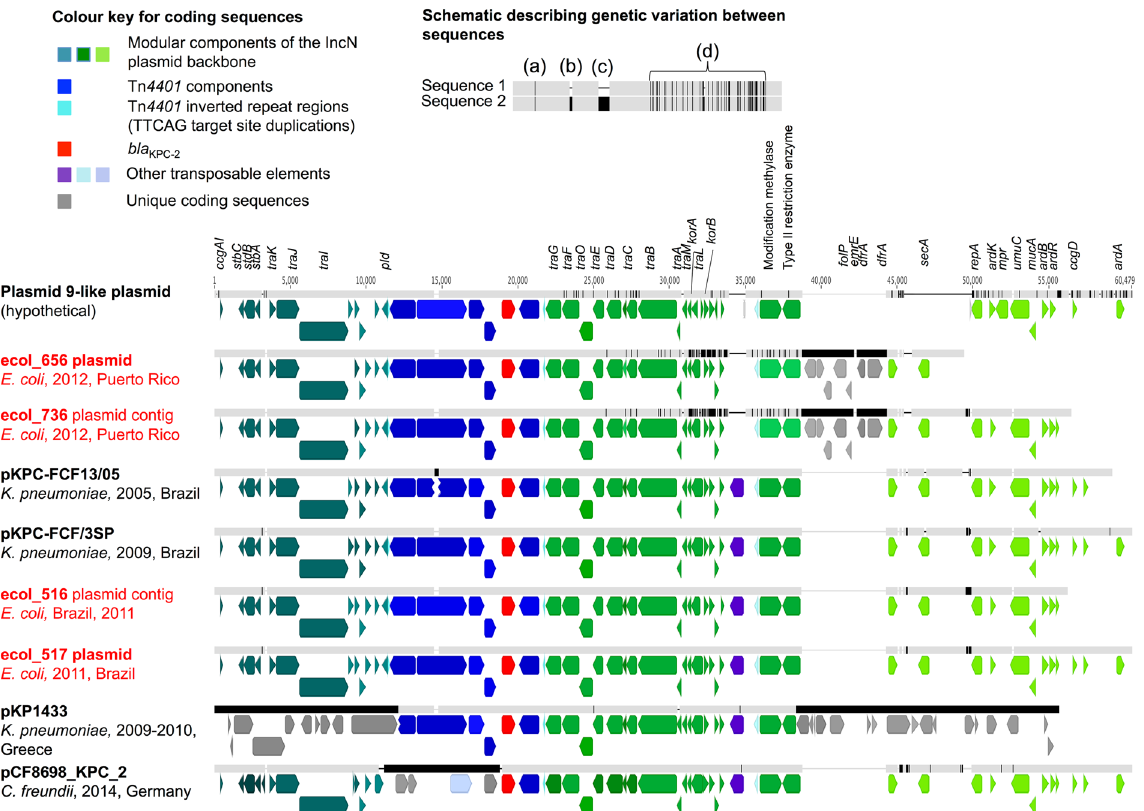
Figure 2. Comparison schematic of FJ223607-like (Plasmid 9-like) IncN plasmids (publicly available; this study), and their geographic origin/dates of isolation. Plasmid sequence names in red are those from this study, derived from PacBio data and closed (ecol_517, ecol_656) or incomplete plasmid structures (ecol_516, ecol_736) derived from Illumina data. Aligned bars adjacent to plasmid names represent plasmid sequences: light grey denotes regions with 100% sequence identity; black represents nucleotide diversity between sequences; and thin lines represent indels. Coding sequences are represented by fat arrows below individual sequence bars and are colour-coded as per the colour key. The inset schematic describing genetic variation between sequences depicts examples of evolutionary events identified: ( a ) single nucleotide level change, ( b ) small indels ( ≤ 100 bp), ( c ) large indels ( > 100 bp), ( d ) recombination